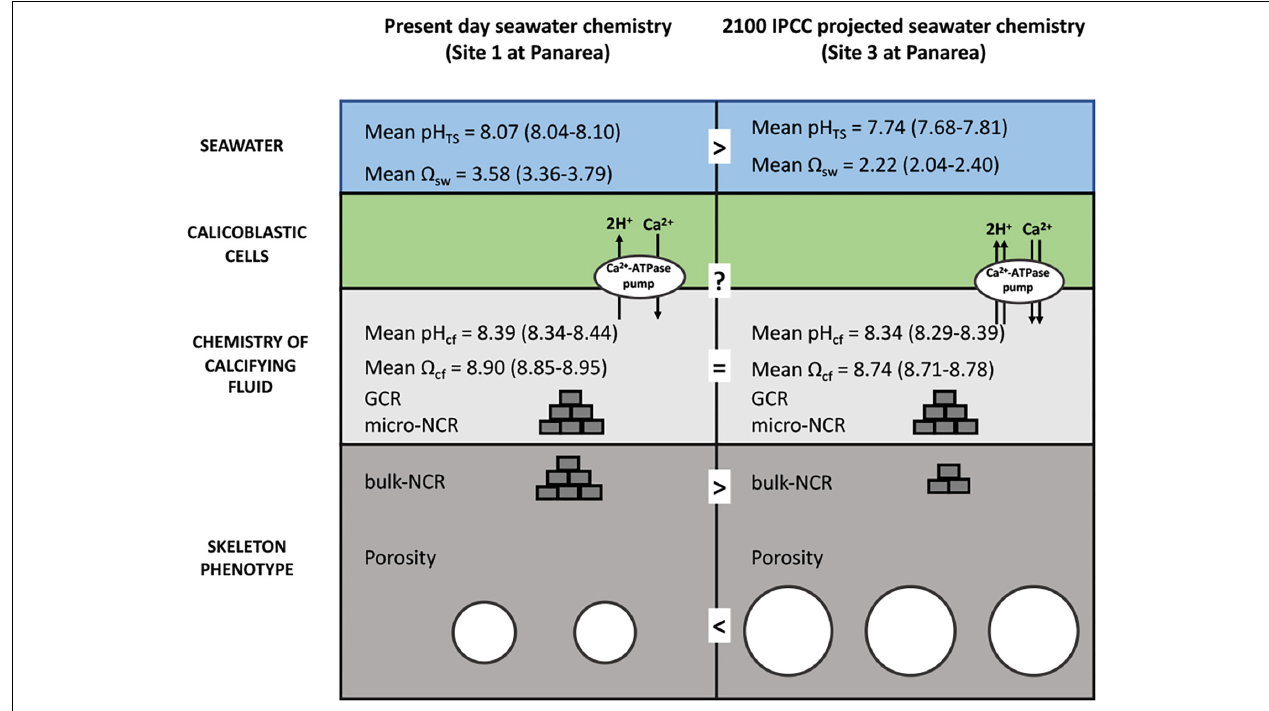
FIGURE 6 | Schematic summary showing the hypothesized impacts of life-long acclimation to low pH on skeletal growth in Balanophyllia europaea along the gradient of Panarea. At the current seawater pH (Site 1), B. europaea up-regulates pH and carbonate chemistry of the calcifying fluid compared to seawater levels. At low pH TS as those projected for 2100 (Site 3), seawater acidification did not significantly affect pH cf and DIC cf , showing comparable values to those of Site 1. Under these conditions, the bio-inorganic model projects no changes of aragonite saturation state ( (cid:127) cf ), thus unmodified GCR and micro-NCR, compared to present-day conditions (Site 1), suggesting that B. europaea performs an effective biological control over the calcification process. Nevertheless, with increased energy expenditure which is likely needed to maintain calcification, B. europaea changes its skeleton phenotype to a morphology characterized by decreased bulk density and increased porosity at the macro-scale, and reduced (measured) bulk-NCR, while maintaining unchanged linear extension rates (Fantazzini et al., 2015). No increases in production of organic matrix proteins (OM) per unit mass of CaCO 3 are observed (Fabry et al., 2008). We postulate a tradeoff in energetic balance in which internal carbonate chemistry is homeostatically compensated at the expenses of calicoblastic cell and organic matrix functioning/organization and macro-scale skeleton structure to maintained coral growth (i.e., linear extension rates) and the reproductive output (Andersson and Mackenzie, 2012; Fantazzini et al.,